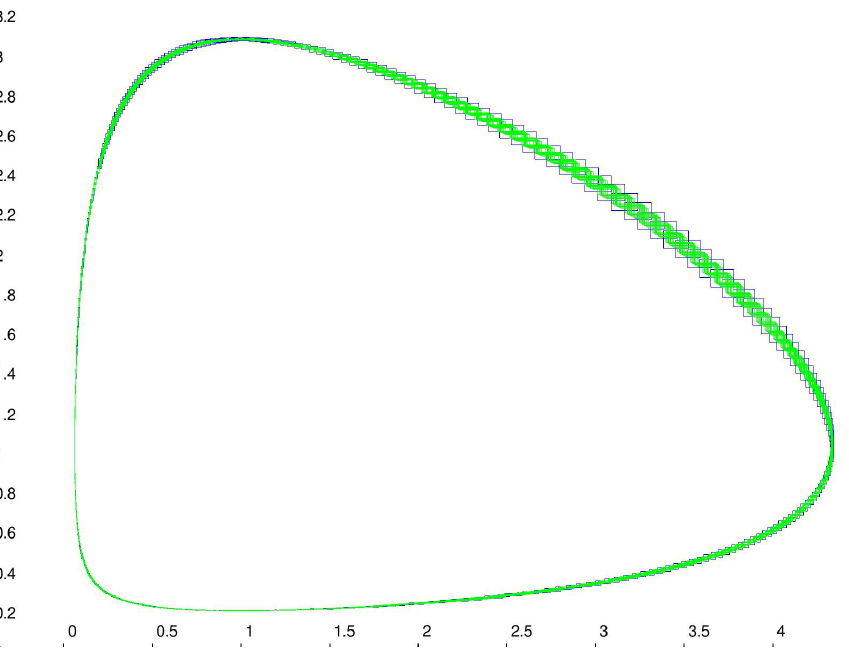
Figure 3. Reachable tube obtained for example (14) ( y 1 w.r.t. y 2 ) and Z 0 as the initial condition in blue. One hundred reachable tubes with the Monte-Carlo approach in